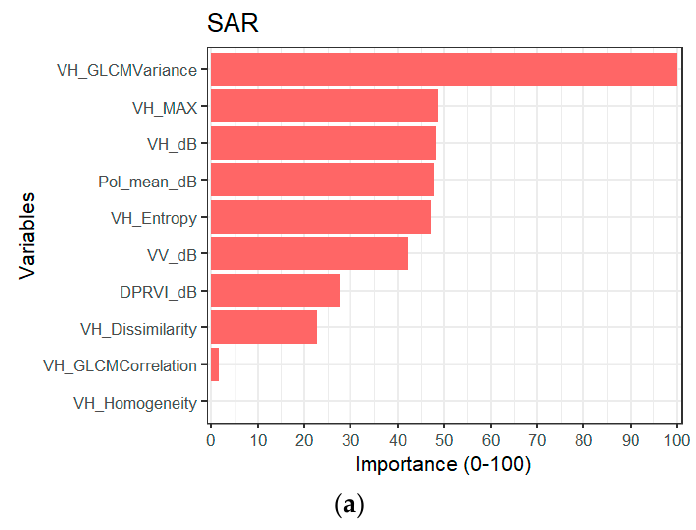
Figure 5. Predicted vs. measured biomass graph for the developed ( a ) optical, ( b ) SAR, and ( c ) SAR–optical predictive models for total stem biomass (TSB) estimation. The black line represents the fitted line, and the red line represents the 1:1 line.